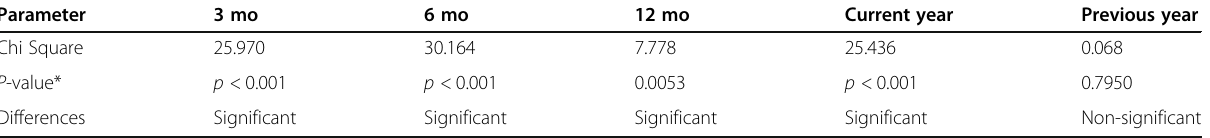
Table 6 Comparison between groups according to the number of recurrences using Pearson ’ s chi-square